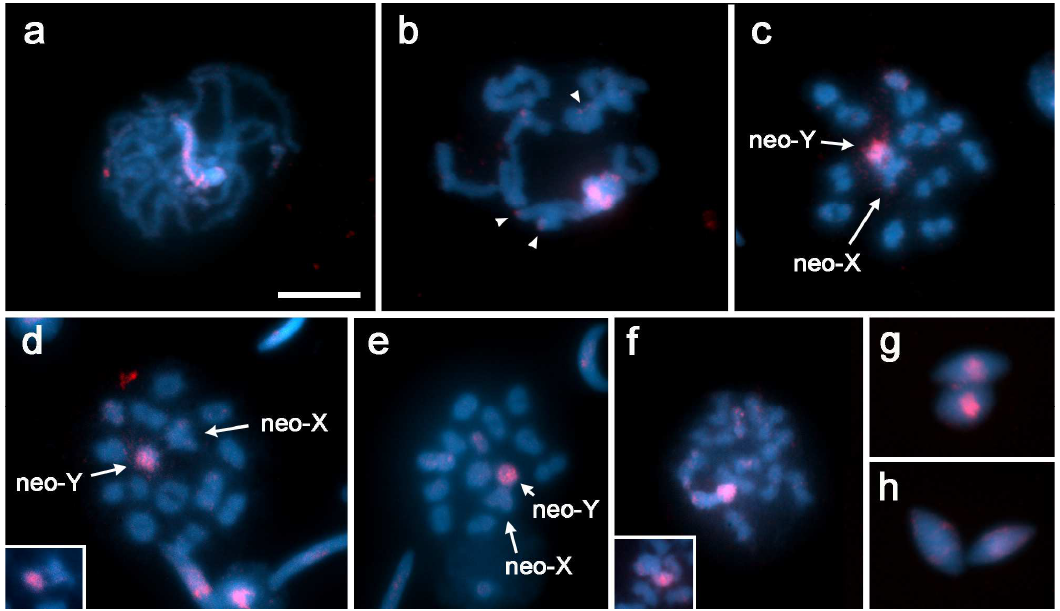
Figure 3. GISH in Rhionaeschna bonariensis (n = 12 + neo-XY). The male gDNA probe was labeled with Cy3-dCTP (red). ( a ) Pachytene; ( b ) diplotene; ( c,d ) diakinesis; ( e ) prometaphase I; ( f ) prophase II; ( g , h ) spermatids with ( g ) and without ( h ) hybridization signals. Arrowheads in ( b ) indicate weak hybridization signals in some telomeric regions of autosomal bivalents. Insets in ( d ) and ( f ) show selected neo-XY bivalents from other cells. Bar = 10 μm.